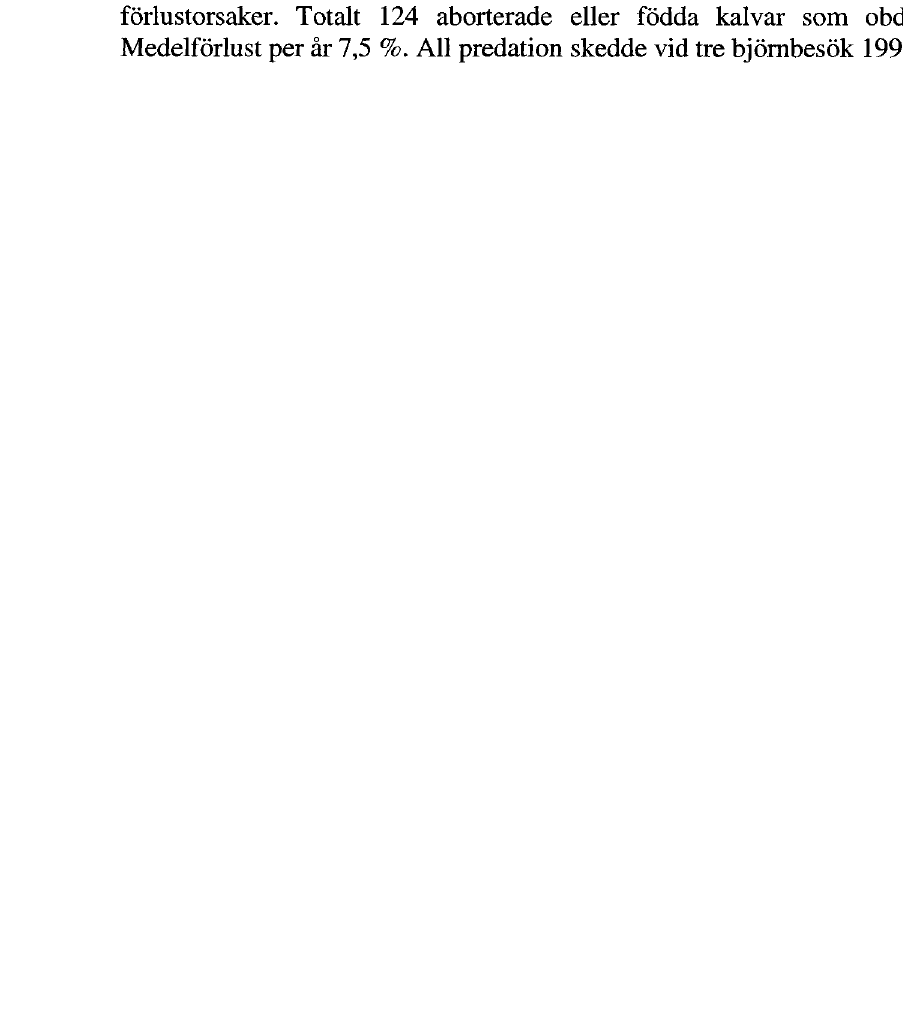
Diagram 1. Causes of perinatal calf losses in reindeer calving in enclosures, 1997¬ 2000. Total number of necropsied reindeer calves (aged 0-1 month); 124. Average calf loss per year 7,5 %. All predation was due to three attacks by brown bear in 1998. Diagram 1. Tidiga kalvforluster hos vårhågnade vajor under 1997-2000, fordelade på forlustorsaker. Totalt 124 aborterade eller fodda kalvar som obducerats, ingår. Medelforlust per år 7,5 %. All predation skedde vid tre bjornbesok